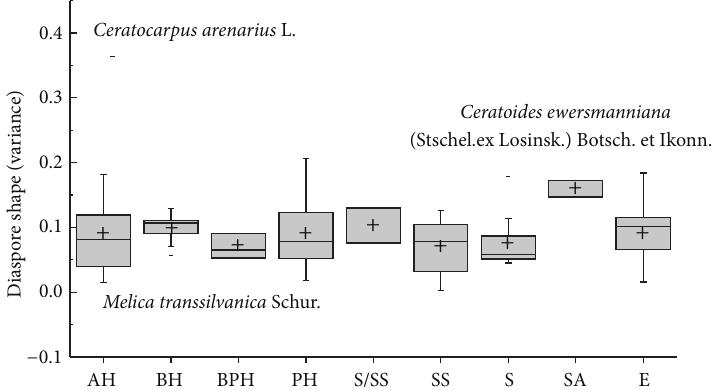
(Stschel.ex Losinsk.) Botsch. et Ikonn.